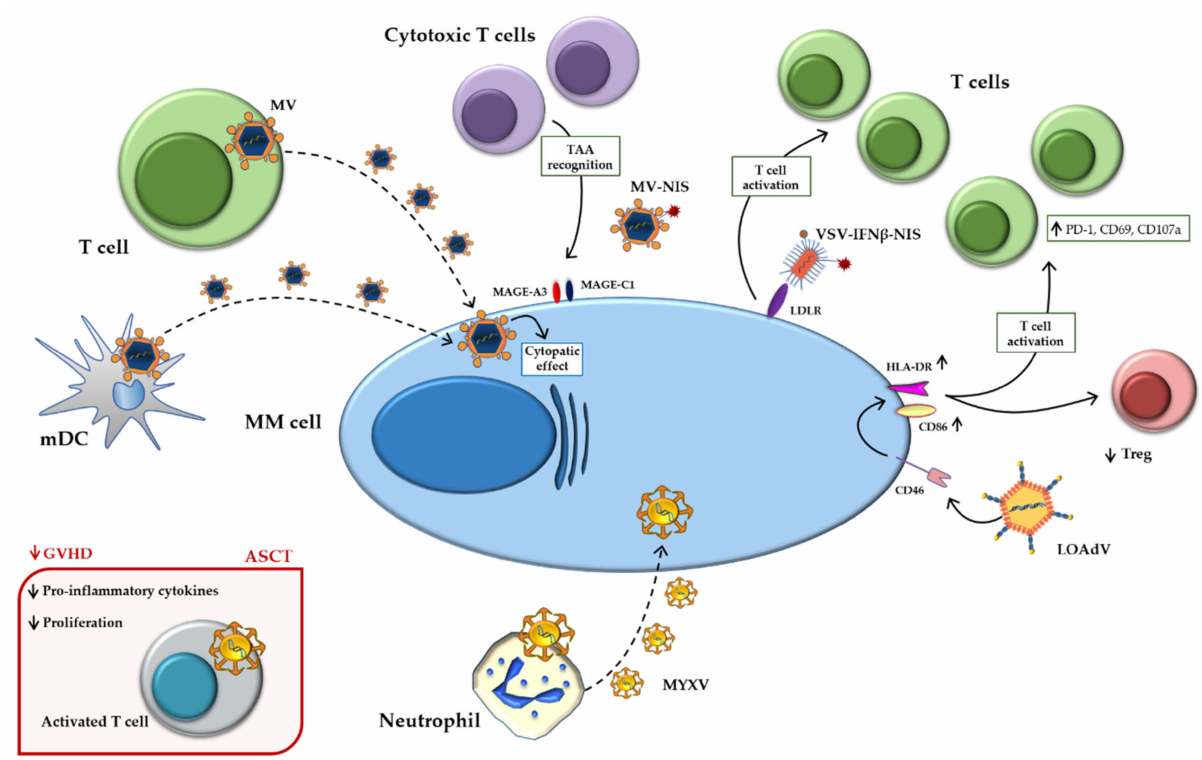
Figure 2. Indirect mechanisms of oncolytic viruses. Schematic representation of indirect mechanisms of oncolytic viruses using immune-microenvironment cells as carriers and active players against MM. Abbreviations: ASCT: Autologous stem cell transplantation; HLA-DR: Human leukocyte Antigen-DR isotype; GVHD: Graft versus host disease; INF β : Interferon β ; LDLR: Low-density lipoprotein receptor; LOAd: Lokon oncolytic Adenovirus; MAGE: Melanoma antigen gene; mDCs: Mature dendritic cells; MM: Multiple myeloma; MYXV: Myxoma Virus; MV: Measles virus; NIS: Sodium iodide symporter; PD-1: Programmed death-1; TAA: Tumor-associated antigen; Treg: Regulatory T cell; VSV: Vesicular stomatitis